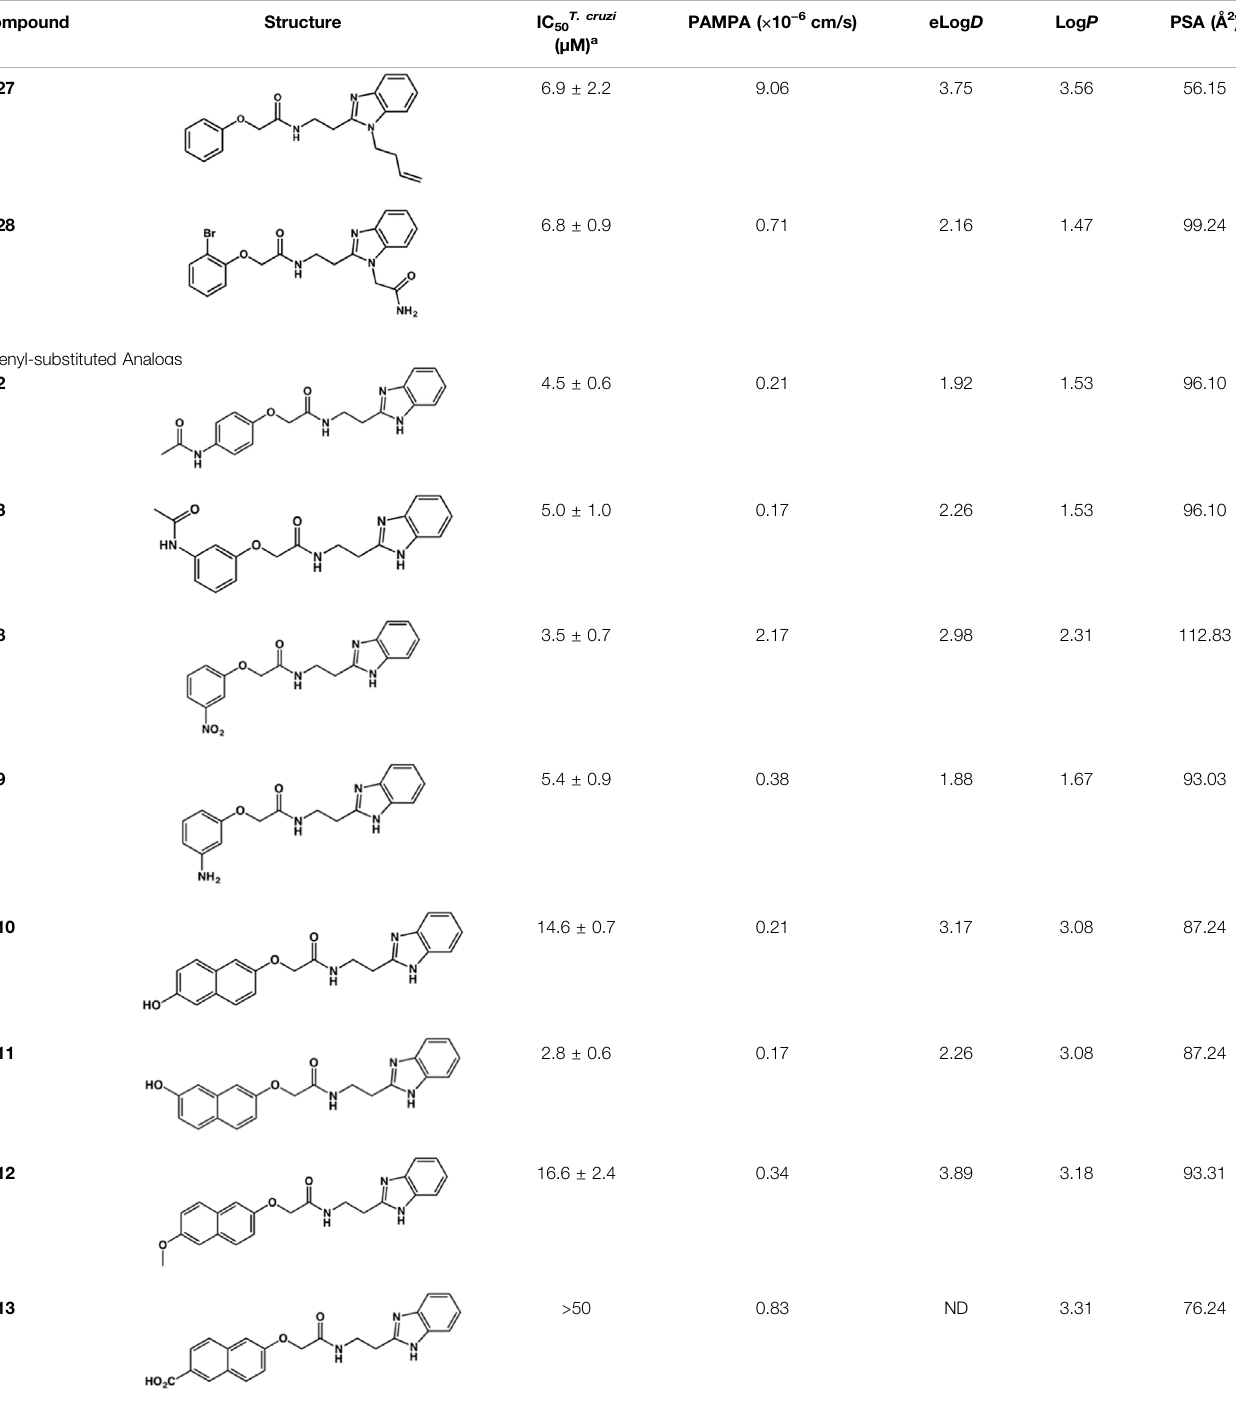
TABLE 3 | ( Continued ) In vitro activity against T. cruzi and physicochemical properties of a subset of the benzimidazoles.